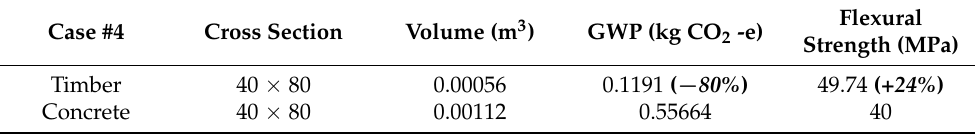
Table 3. GWP of case number 4 compared to concrete of similar